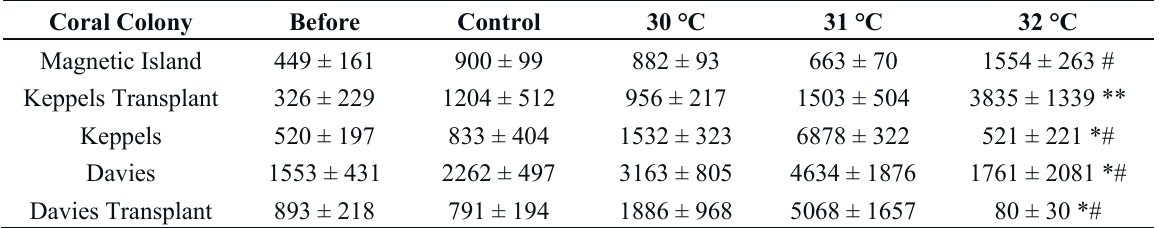
Table 2. Cellular DMSP concentrations (fmol zooxanthellae − 1 ) in colonies of native and transplanted Acropora millepora colonies exposed to before, control, 30 °C, 31 °C and 32 °C treatments in order to measure their contrasting thermal